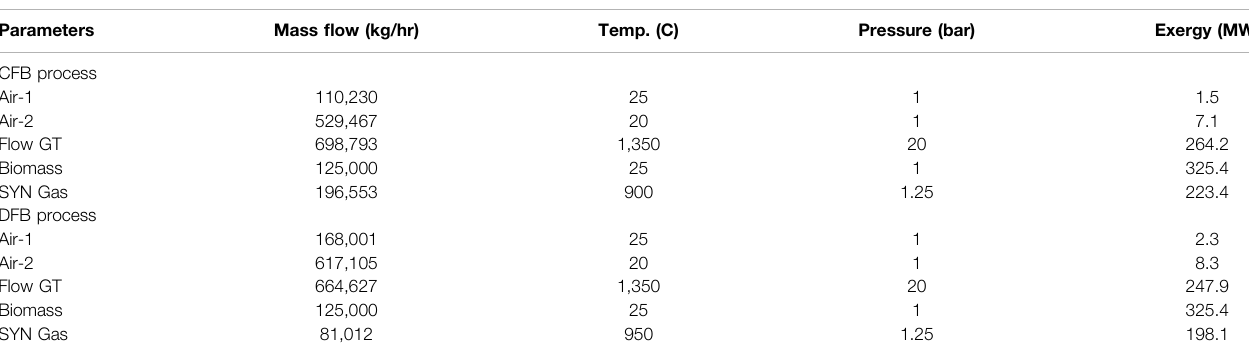
TABLE 4 | Key stream